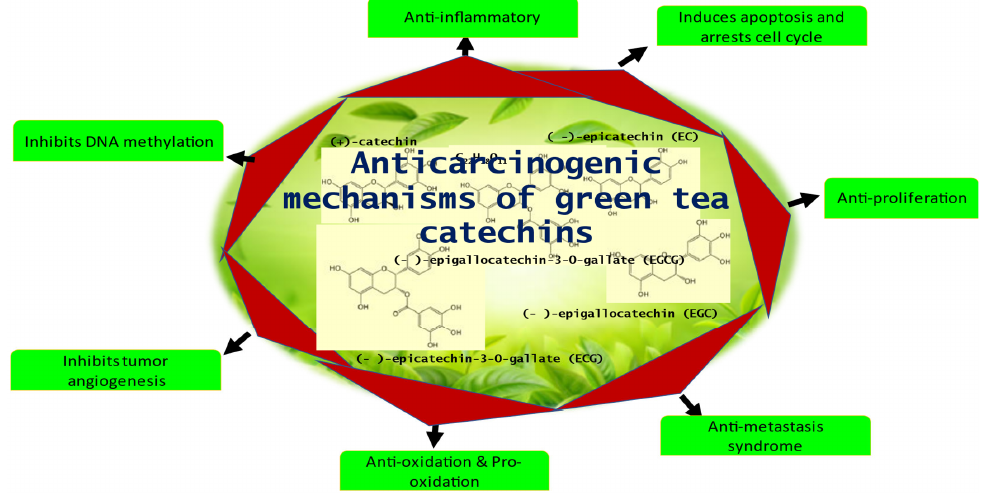
Figure 1. The Anticarcinogenic mechanisms of GTCs.